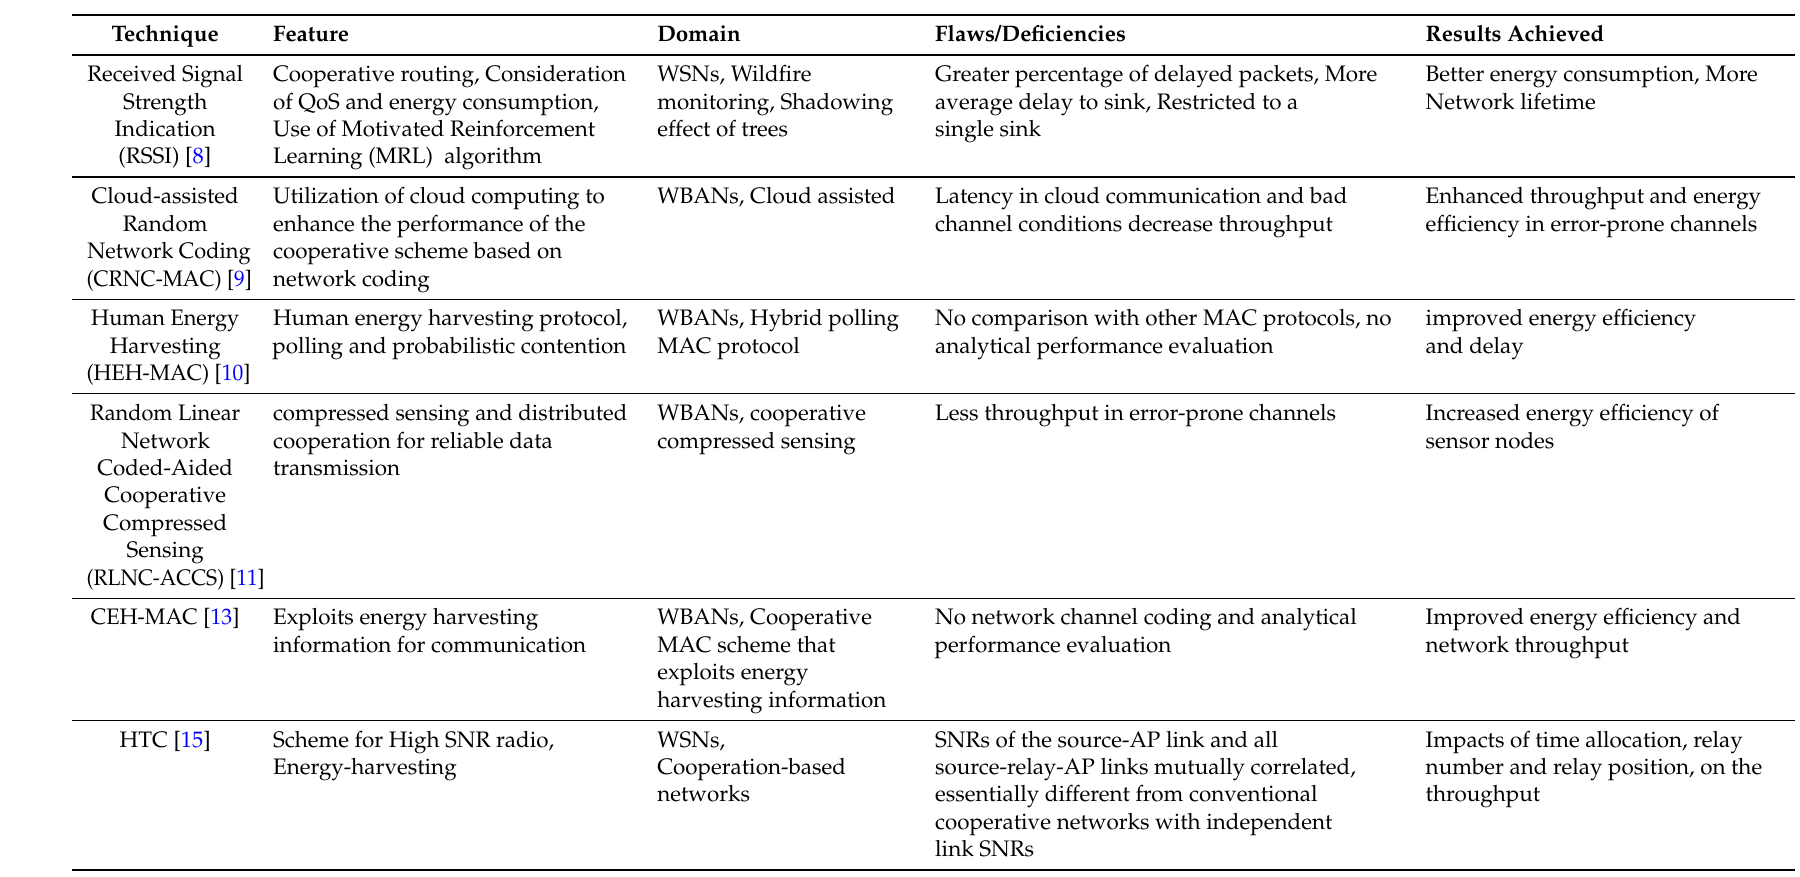
Table 1. Comparison of the state-of-the-art work. RLNC, Random Linear Network Coding; CEH, cooperative energy harvesting; HTC, harvest-then-cooperate; MDTED, modified double-threshold energy